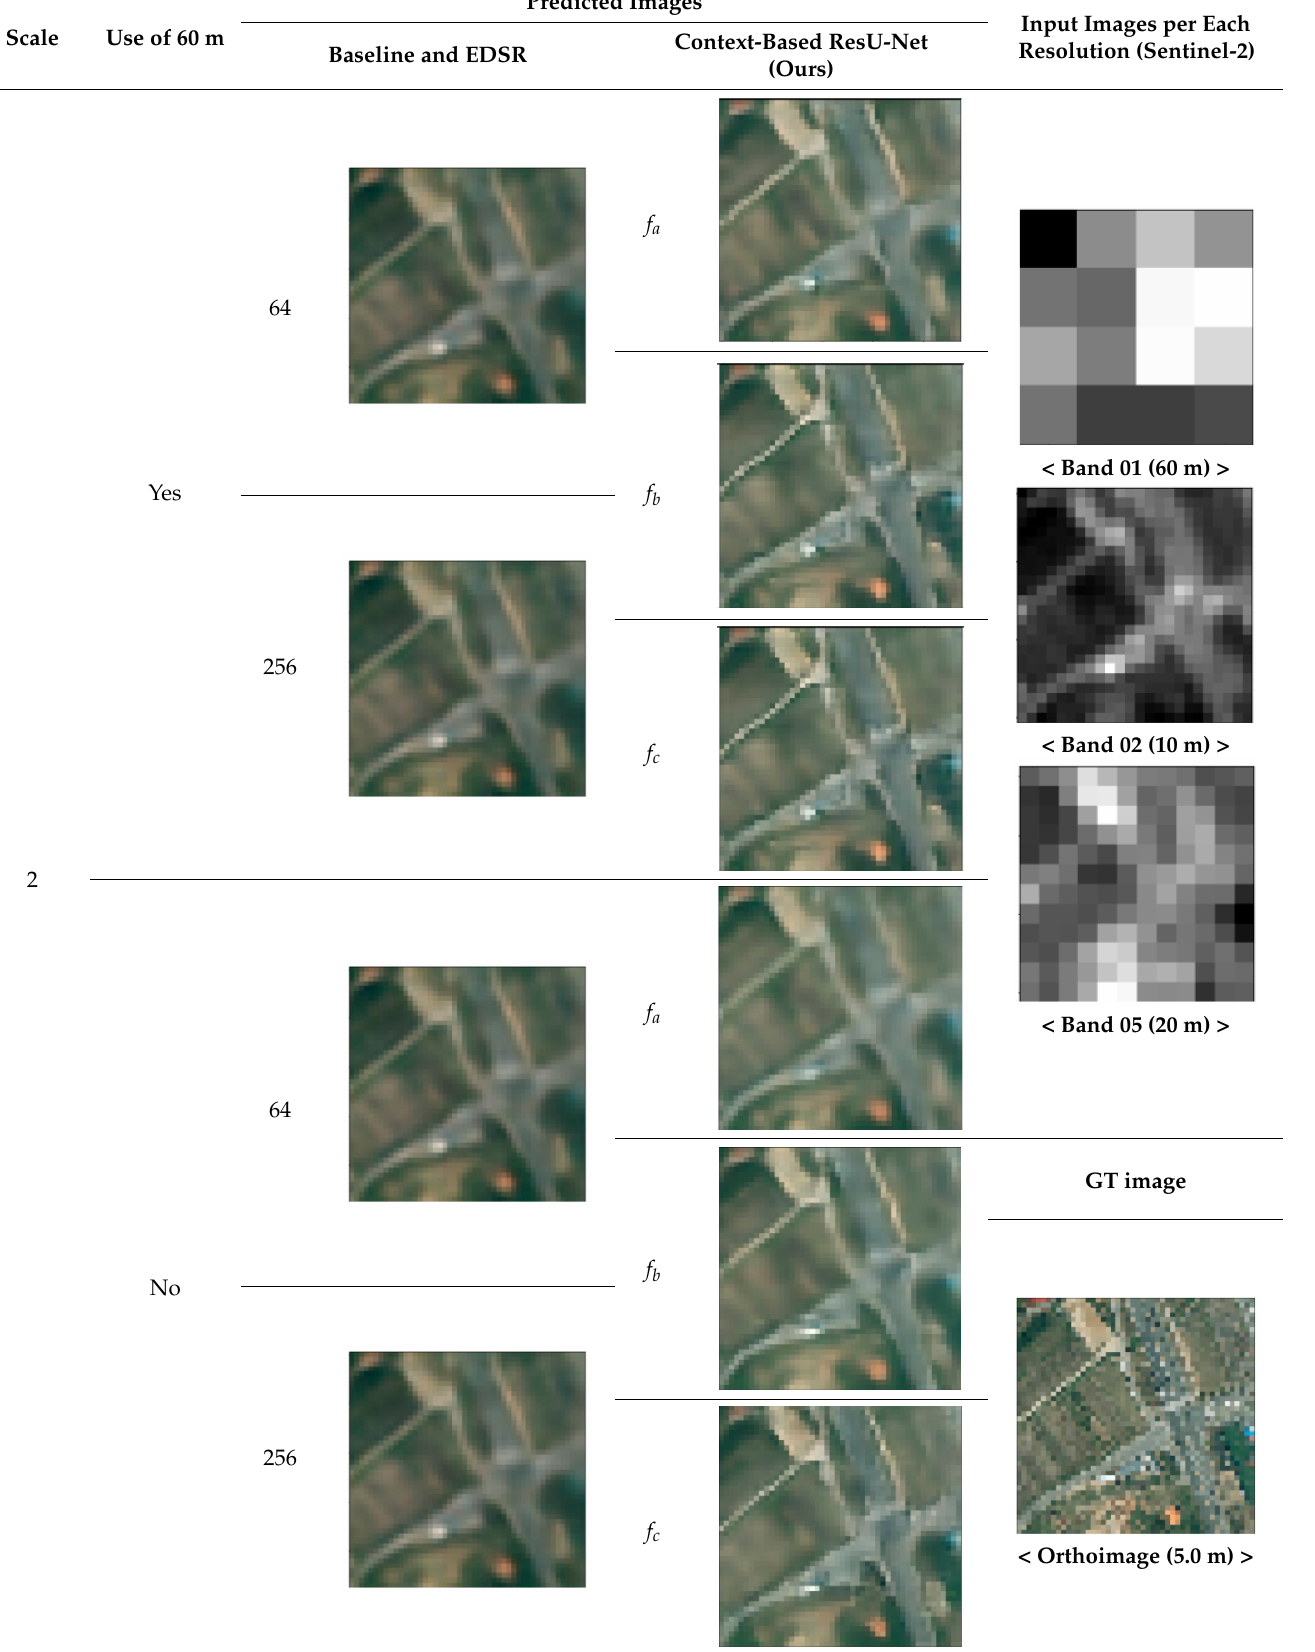
Table 5. Predicted images of Sentinel-2 and corresponding GT image (paddy/road